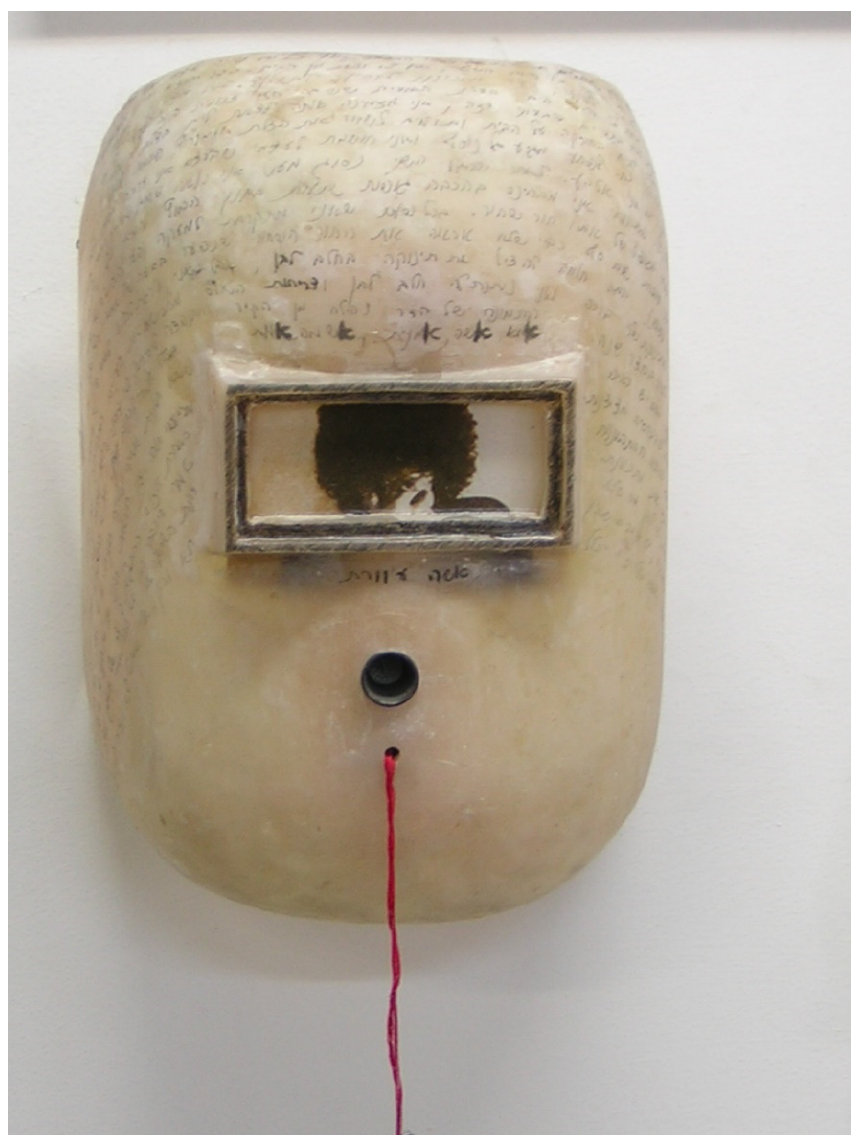
Figure 6. Dvora Morag, “Blind Woman”, 2004. Mixed Media. Photo: Avi Amsalem. To My Daughter (2006) (Figure 7) offers a different approach to the loss of voice and gaze. Here, red threads descend from the artist’s hands (photographs of hands coated with polyester) that embroider the following text on a white, silk cloth: “your words bleed into me drip into my blind stain we are holding onto a vacuum that is between us translucent and clear the space between us adorned with pearls of words that we asked of a treasure not ours”. I believe that the onrush of words—without punctuation, embroidered like